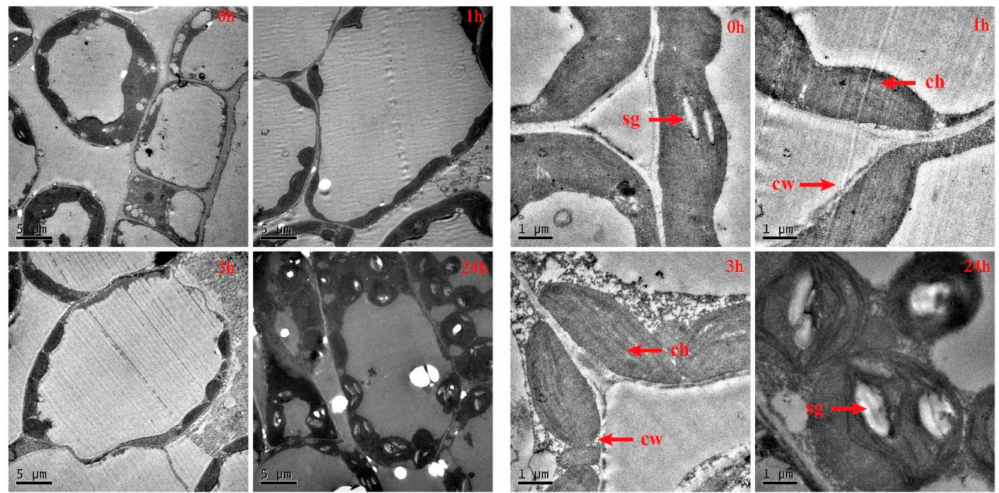
Figure 2. The transmission electron micrographs of chloroplast in the mesophyll cell which winter Brassica napus was exposed to in − 2 ◦ C with a continuous treatment (0, 1, 3, 24 h). The figure on the right magnification is × 4000; the figure on the right magnification is × 20,000. ch: chloroplast, sg: starch grain, M: mitochondria, CW: cell wall.